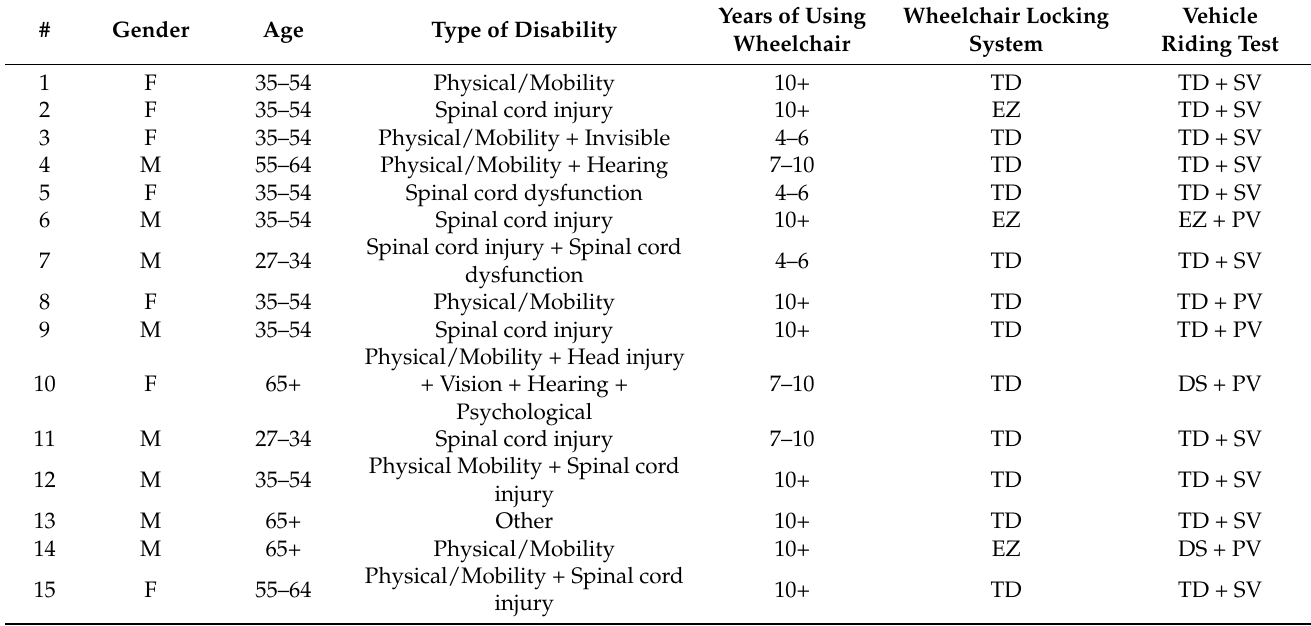
Figure 7. Whole-body exposure analysis of 4-TD and QLX wheelchair docking systems. Table 1. Descriptive of study